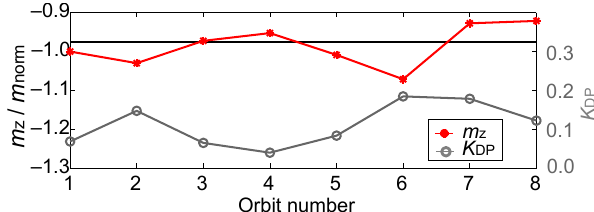
Figure 3. Estimated dipole moments (red) using cost function (32) and the value of the cost function at its minimum normalized to the number of data points of the respective magnetosheath transi- tion (grey). The dipole moments are normalized to m norm = 8 . 0 × 10 15 Tm 3